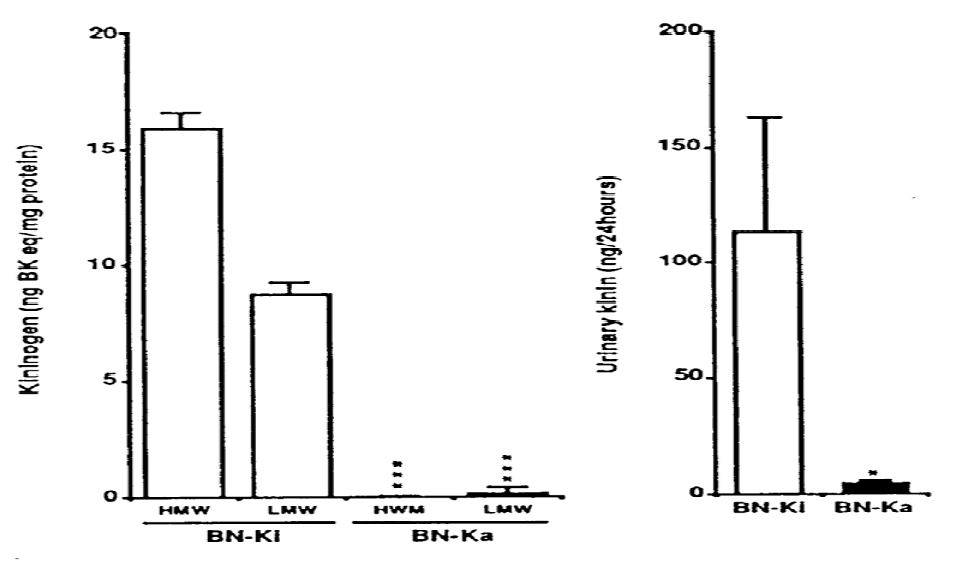
Figure 4. Kininogen levels in plasma (left panel) and excreted kinin levels in urine (right panel) in normal Brown Norway Kitasato (BN-Ki) rats and kininogen-deficient BN-Katholiek (BN-Ka) rats. Values are means ±S.E.M. of four rats. Values in BN-Ka rats were compared with those in BN-Ki rats. *P < 0.05, ***P < 0.001. BK eq, bradykinin equivalent; HMW, high molecular weight: LMW, low molecular weight (reproduced from Ref. [145] with